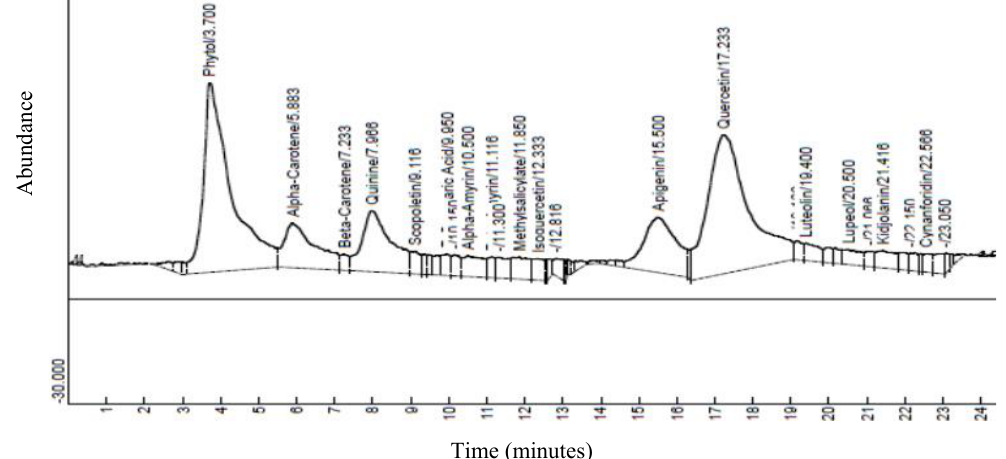
Fig. 2. Chromatogram of phytochemicals in a fractionated extract of Leptadenia